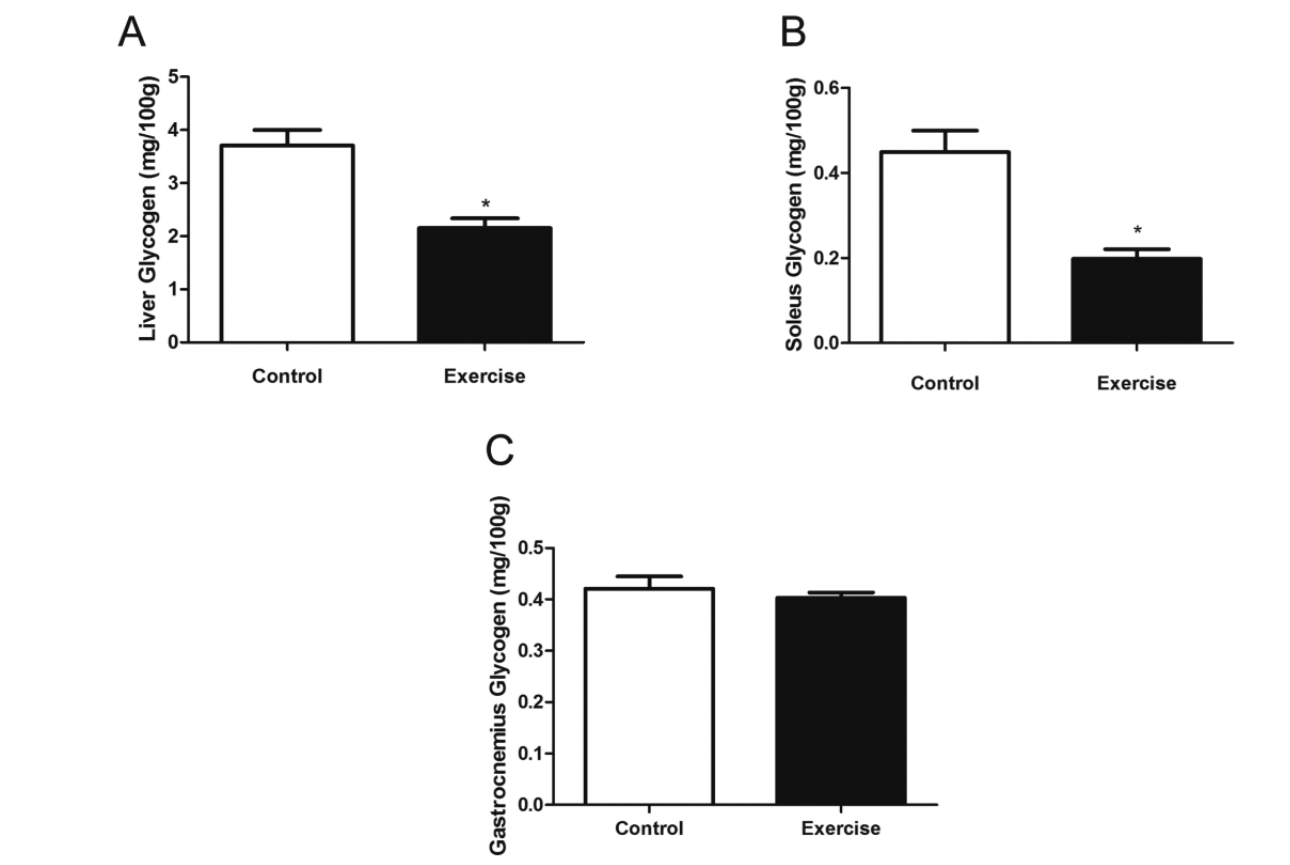
0.05.Figure 3. (A) Glycogen concentrations in the liver after a single exhaustive resistance exercise session. (B) Glycogen concentrations in the soleus muscle after a single exhaustive exercise session. (C) Glycogen concentrations in the gastrocnemius muscle after a single exhaustive exercise session. Each bar represents the mean ± SEM of rats. * different from Control group; P <